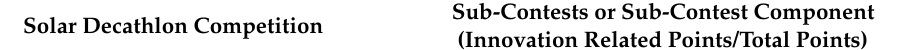
Table 1. Solar Decathlon competitions’ sub-contests related to innovation. The asterisk indicates competitions that were considered for the analysis in this